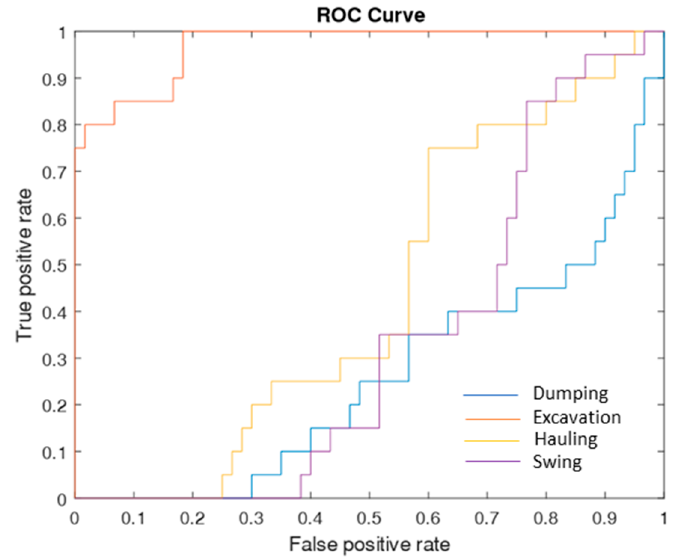
Figure 8. ROC curve for different activities of the excavator.